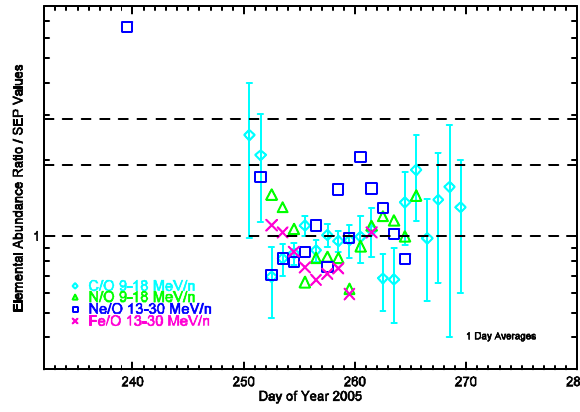
Fig. 4b. Daily averaged elemental abundance ratios C/O and N/O Figure 4b. Daily averaged elemental abundance ratios C/O and N/O for the energy range 9-18 for the energy range 9–18MeV and Ne/O and Fe/O in the energy interval 13–30MeV/n also normalized to the reference composition MeV and Ne/O and Fe/O in the energy interval 13-30 MeV/n also normalized to the reference given by Mason and Sanderson composition given by Mason and Sanderson [1999].